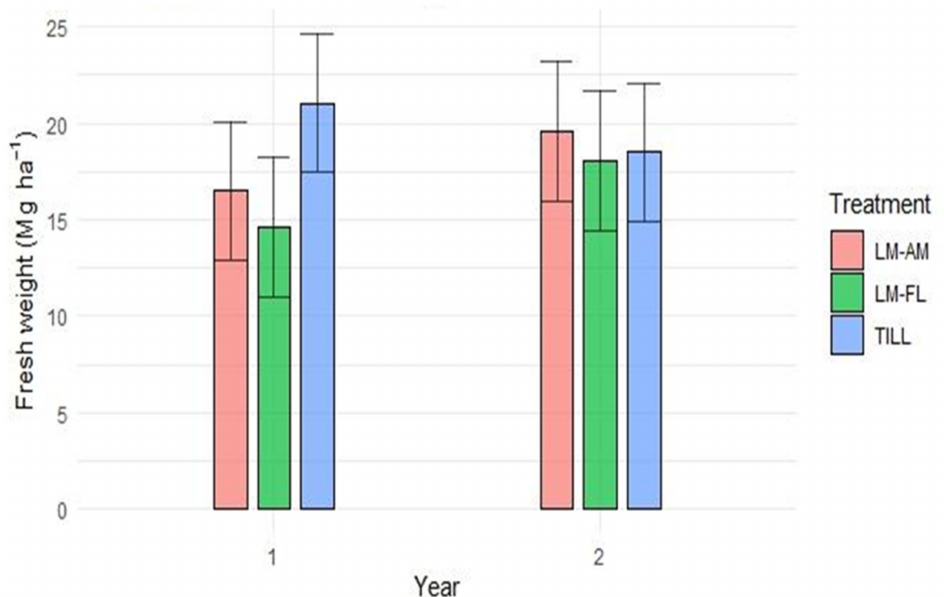
Figure 1. Effect of treatments (TILL, conventional tillage system; LM-FL, living mulch-based system managed with flaming; LM-AM, living mulch-based system managed with an autonomous mower) and years (1 is 2019, 2 is 2020) on cauliflower fresh marketable yield. Error bar represents the upper and lower limits of the 95% confidence